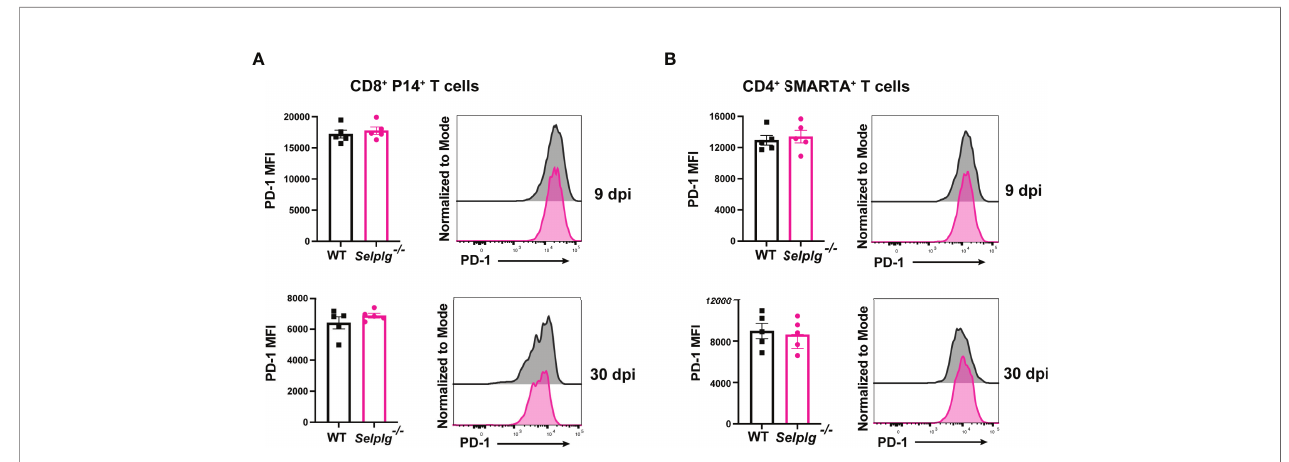
FIGURE 3 | Selplg -/- CD4 + and CD8 + T cells express high PD-1 levels. Spleens were isolated from Cl13 infected mice at day 9 and 30dpi. Mean fl uorescence intensity (MFI) and representative histogram of PD-1 expression levels on WT and Selplg -/- P14 + T cells (A) and SMARTA + T cells (B) . Data are representative offour independent experiments all with fi ve or more mice per group (error bars, s.e.m.).